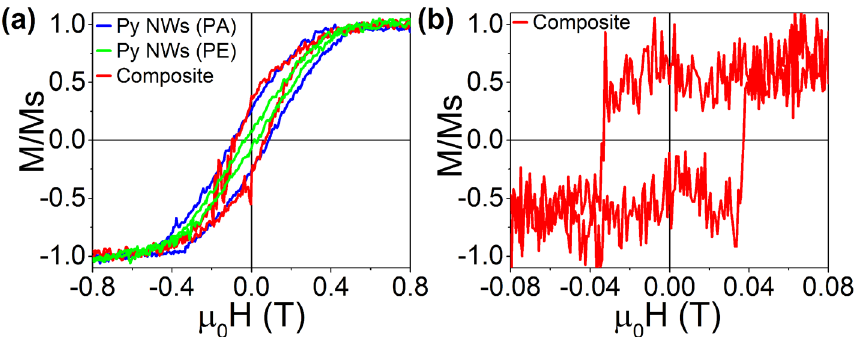
Figure 7. Room temperature hysteresis loops of composite with measurements of ( a ) VSM and ( b ) MOKE. For ( a ) measurements are performed with the applied field parallel (PA) to the NWs long axis inside AAO (blue line), perpendicular (PE) to the NWs long axis inside AAO (green line) and parallel to the substrate of composite (red line). For ( b ) measurements are realized parallel to the substrate of the composite (red